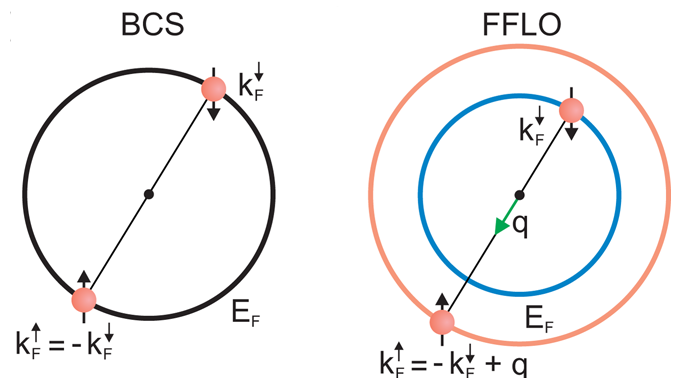
Figure 1 . a) Splitting of the free-electron parabola in a magnetic field lead- Figure 1. Color online. From Wosnitza [35] On the left, the traditional BCS Cooper pair is represented. ing to Pauli paramagnetism and di ff erent Fermi momenta for spin-up and On the right, the energy of the up and down electrons have been shifted by the magnetic field. spin-down electrons. b) Schematic sketch of (left) the usual BCS pairing state with zero resulting momentum and spin and (right) the FFLO pair- A momentum q can be added to one of the electrons to create a zero momentum center of mass Cooper ing state with a finite center-of-mass momentum, q . The circles represent pair. In the diagram, the initial momentum of the electrons is isotropic. In real material, the shape of the Fermi surfaces for spin-up and spin-down electrons. the Fermi surface could create more complex not one of the originally predicted FFLO states, but might be interpreted as a more complicated version thereof [ 19 ]. Further- more, careful thermodynamic experiments showed that the en- tropy decreases when going from the homogenous supercon- ducting into the Q phase in CeCoIn 5 , contrary to the entropy in- crease expected for the evolution of the FFLO phase, but in line with the emergence of antiferromagnetic order. [ 20 ] As visualized in Figure 2 , electronically low-dimensional ma- terials have a strongly enlarged stability region for the FFLO phase compared to 3 D metals. Prime candidates for the real- ization of FFLO phases are, therefore, quasi- 1 D [ 21 ] or 2 D met- als, such as organic superconductors. Whereas, so far, no clear signs for FFLO states have been reported for quasi- 1 D super- conductors, very strong evidence for such states is found for the 2 D organic metals. For these, the orbital pair breaking is greatly suppressed when the magnetic field is applied parallel to the conducting layers. Indeed, the well-studied 2 D organic su- perconductors based, for example, on the organic molecules ET ( = BEDT-TTF = bisethylenedithio-tetrathiafulvalene) or BETS ( = bisethylenedithio-tetrathiafulvalene) have all the ingredients necessary for FFLO states to occur. [ 22 – 25 ] These strong type-II spin-singlet superconductors are of high purity with long mean free paths and have close to ideal two-dimensional electronic properties.